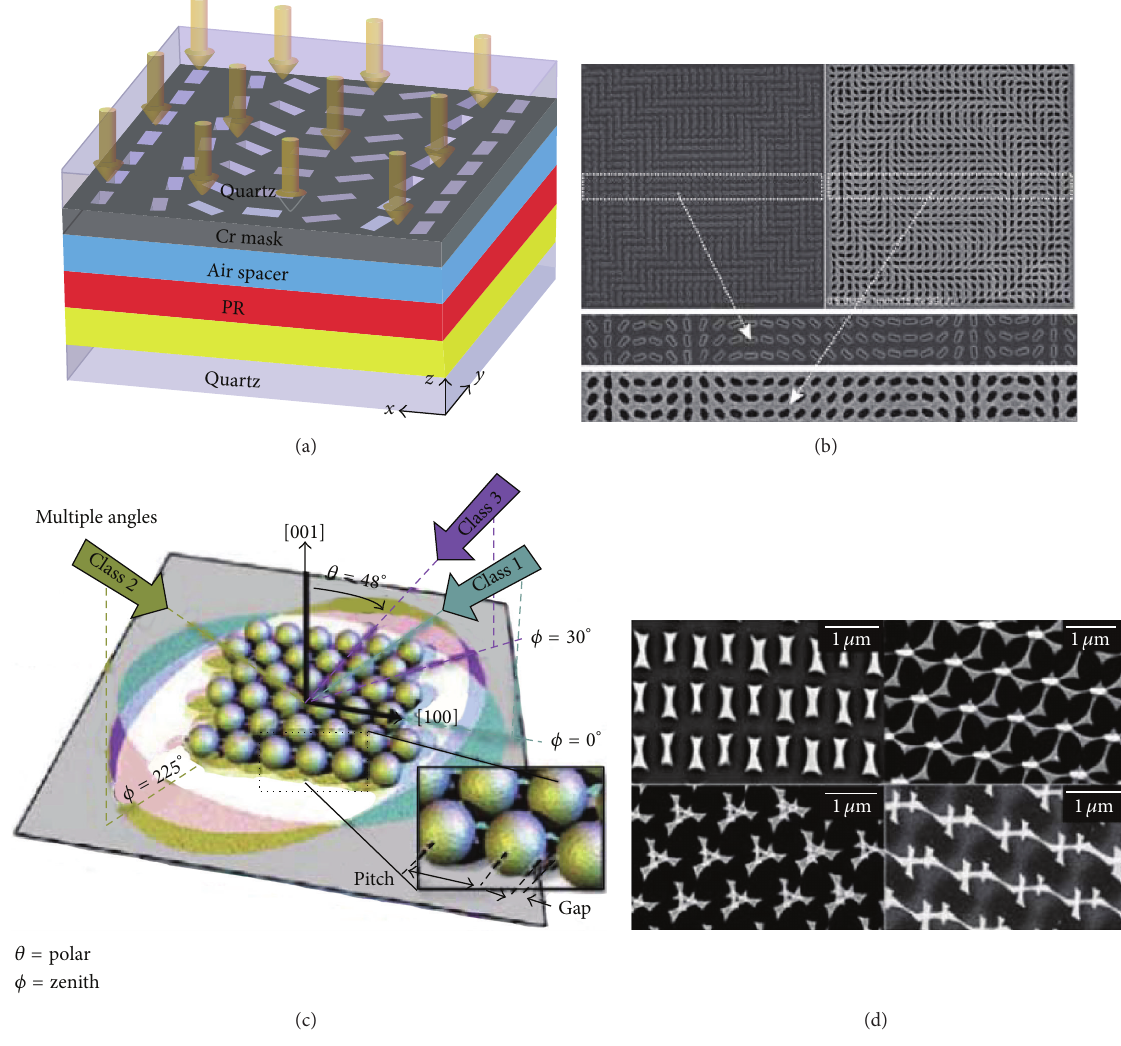
Figure 54: Novel fabrication techniques for optical metasurfaces. (a) Schematic of the surface plasmon lithography and simulated intensity distributions for a metasurface lens. (b) SEM images of the mask (left) and fabricated sample (right). (c) Schematic of the multiangled NSL. (d) SEM images of fabricated samples. (c, d) Figures are reproduced from